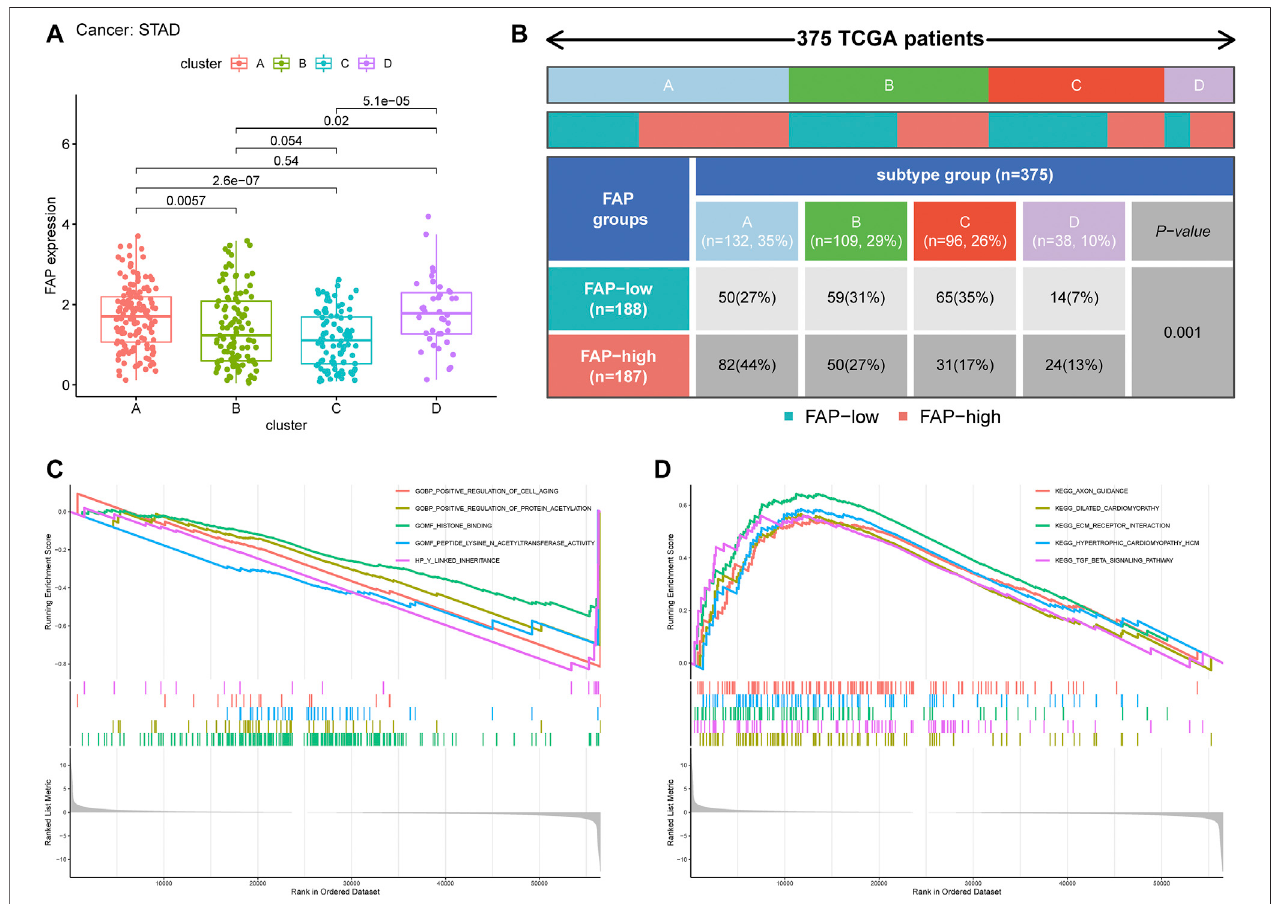
FIGURE 6 | Clinical correlation of different subtypes. (A) Distribution of FAP expression across the four STAD subtypes. (B) Heat map and table showing the distribution of FAP expression levels among the different subtypes. (C and D) The results of GSEA based on GO database (C) and KEGG (D) in subtype C.